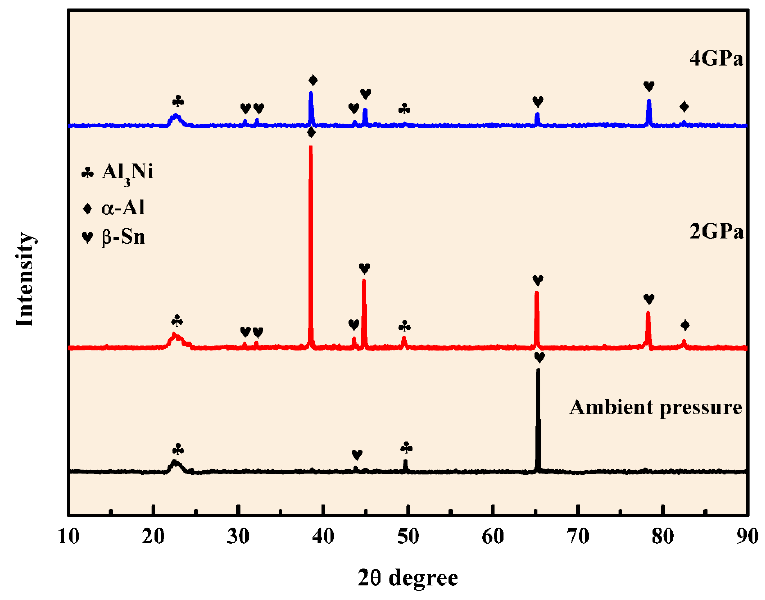
Figure 1. The phase composition of Al-5.4Ni-2Sn alloy solidified under different pressures.